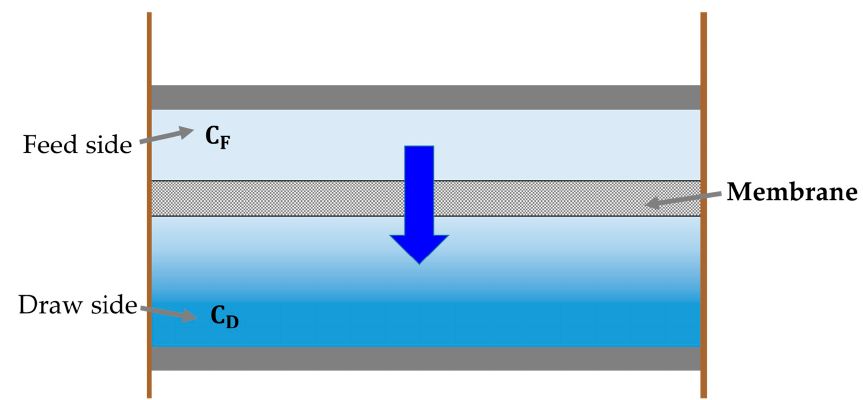
Figure 8. The schematic illustration of a reversible membrane-based process. In accordance with the ideal assumptions, only water on a feed side permeates to a draw side through a membrane, and salts in the draw side do not transfer to the feed side.